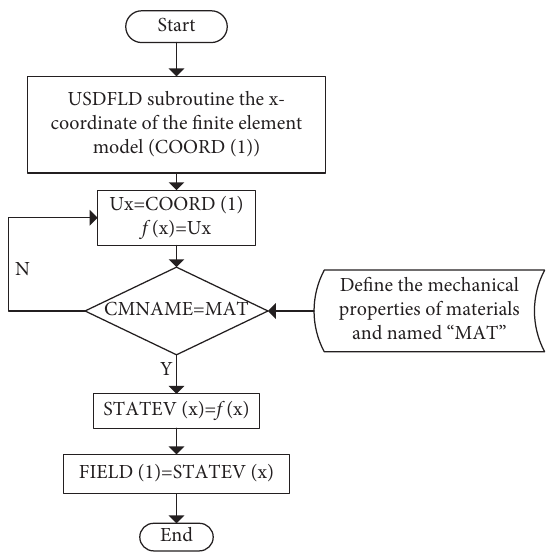
Figure 4: The flow chart of the USDFLD